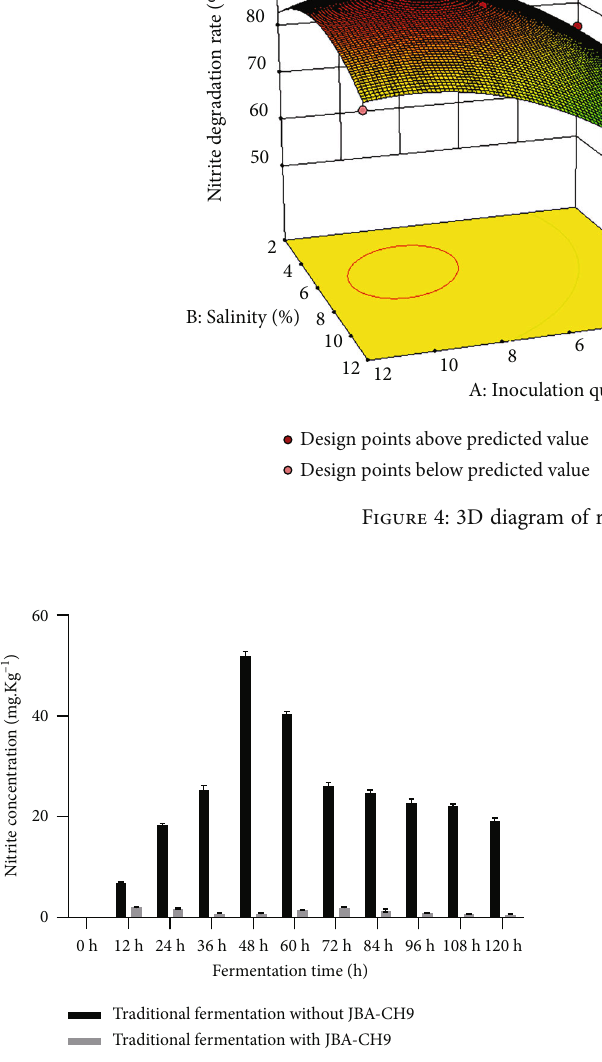
Figure 5: Changes of nitrite concentration during soy sauce fermentation.